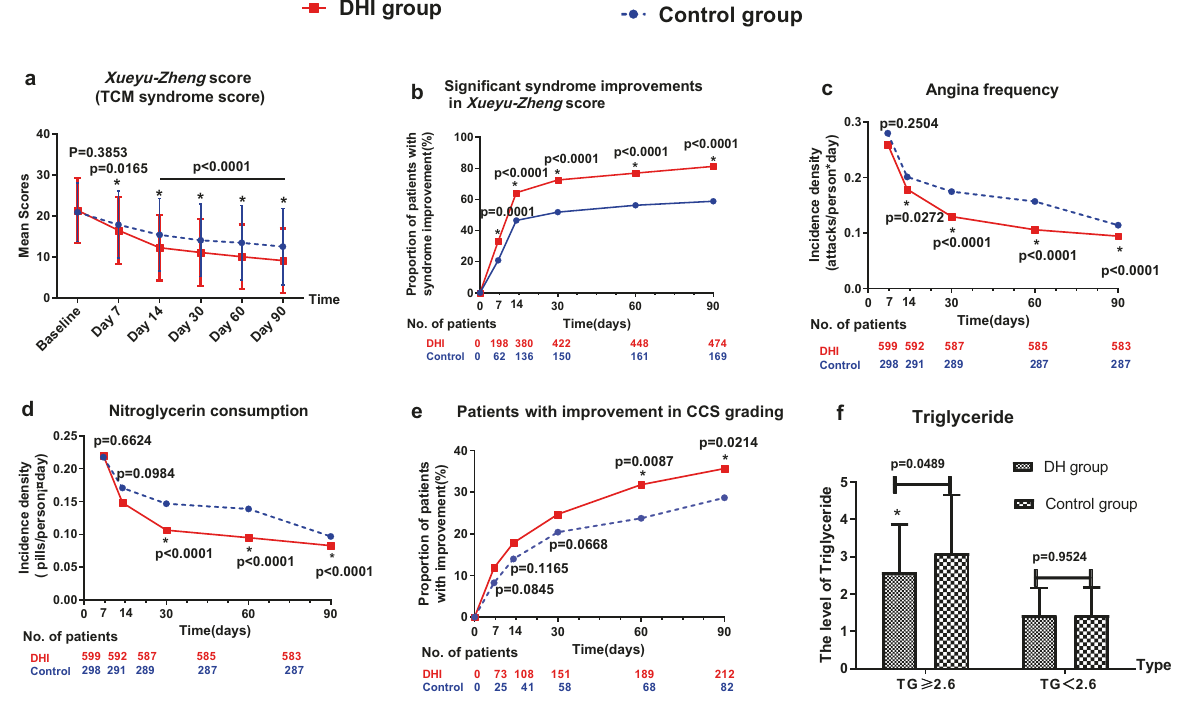
Fig. 3 Changes in other secondary outcomes between the two groups. a Comparison of mean Xueyu-Zheng scores at each time point. b The proportion of patients with signi fi cant improvements in Xueyu-Zheng scores (%). c Changes in the incidence density of angina (attacks/person- day) according to patients ’ diaries. d Changes in the incidence density of nitroglycerin consumption according to patients ’ diaries. e The proportion of patients with normal ECG recordings. f The proportion of patients with improved CCS